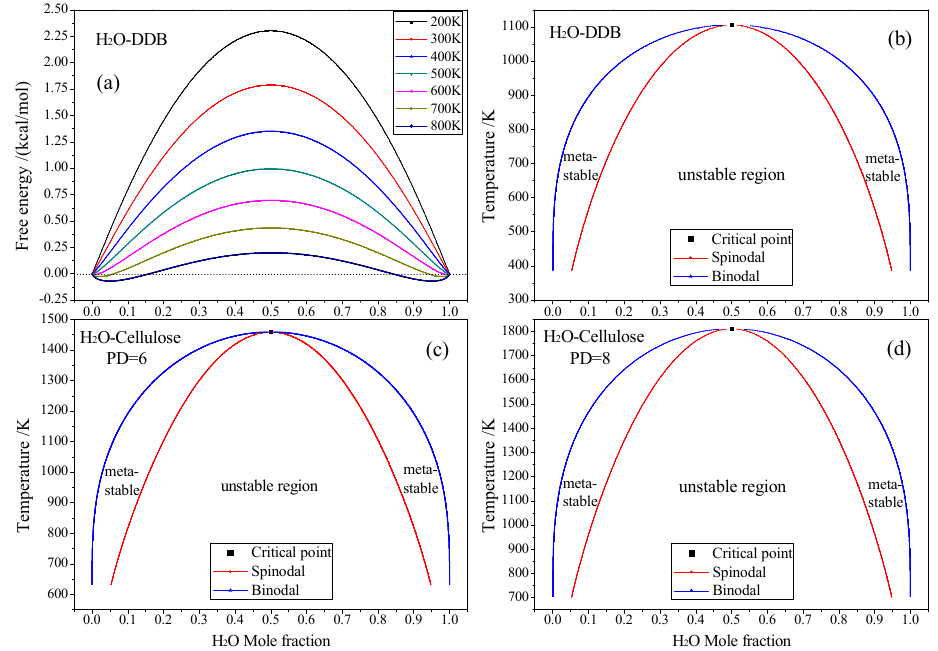
Figure 3. ( a ) The free energy of mixing for H 2 O-DDB mixture varying with Mole fraction for 200–800 K temperatures, mixture phase diagrams of ( b ) H 2 O-DDB; ( c ) H 2 O-Cellulose (PD = 6) and ( d ) H 2 O-Cellulose (PD = 8).